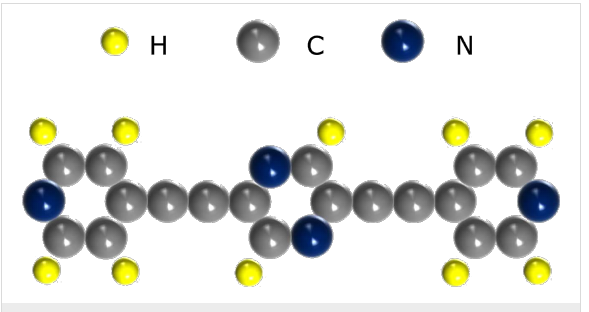
Figure 1: A schematic molecule structure of 1